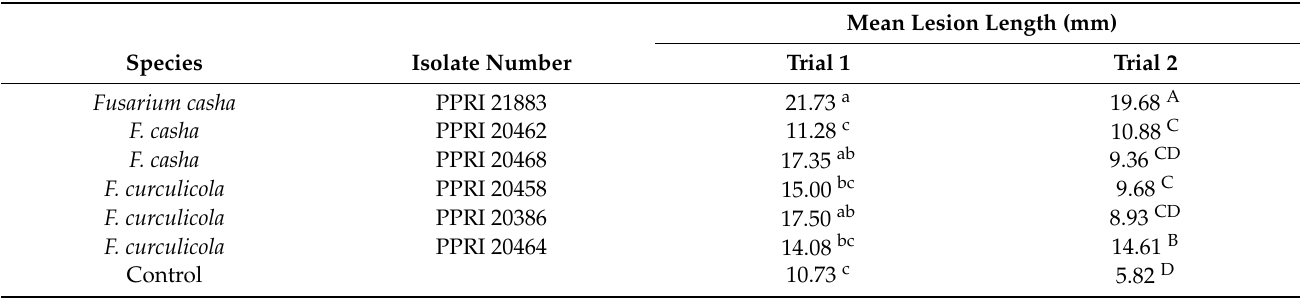
Table 4. Results of pathogenicity tests with Fusarium casha and F. curculicola on Amaranthus cruentus